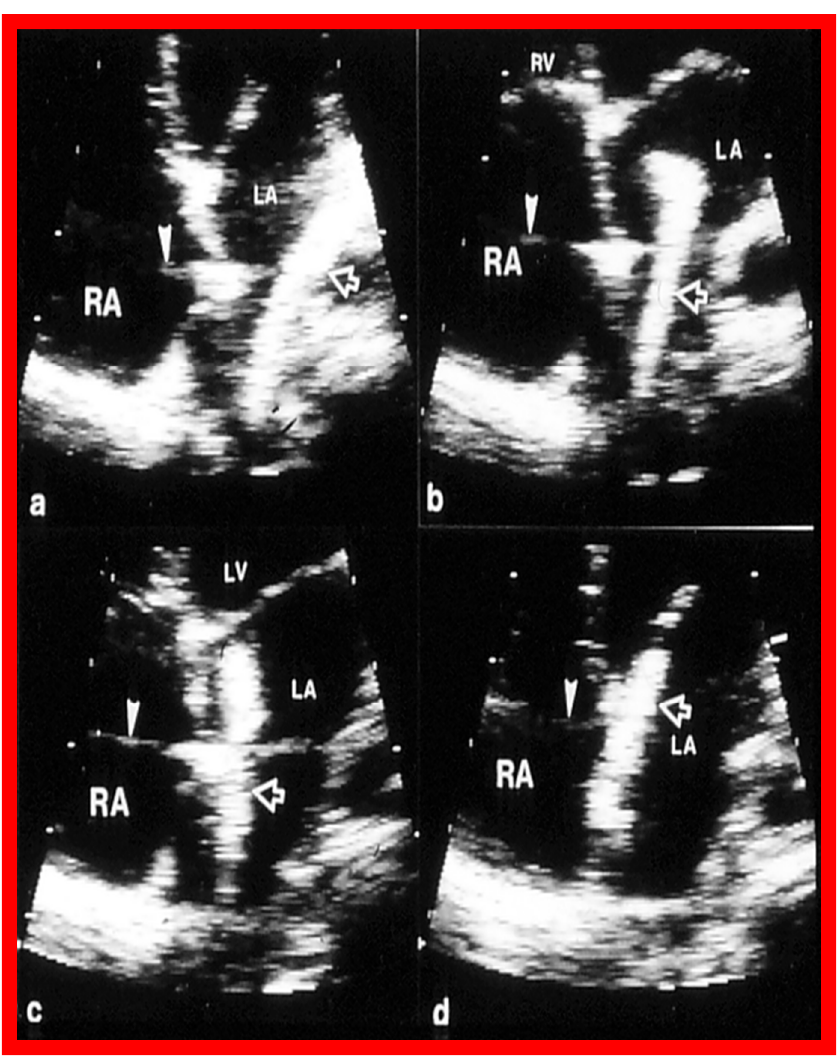
Figure 26. Precordial echo frames from apical four-chamber views of the atria during the deployment of a buttoned device (unfilled arrowheads) to occlude an atrial septal defect (ASD). The occlude component of the device is in the left atrium (LA) and frames ( a – d ) demonstrate the occluder being slowly withdrawn towards the ASD to close the atrial defect. The filled arrowheads points to the loading wire attached to the occluder. LV, left ventricle; RA, right atrium; RV, right ventricle. Reproduced from Reference [25].